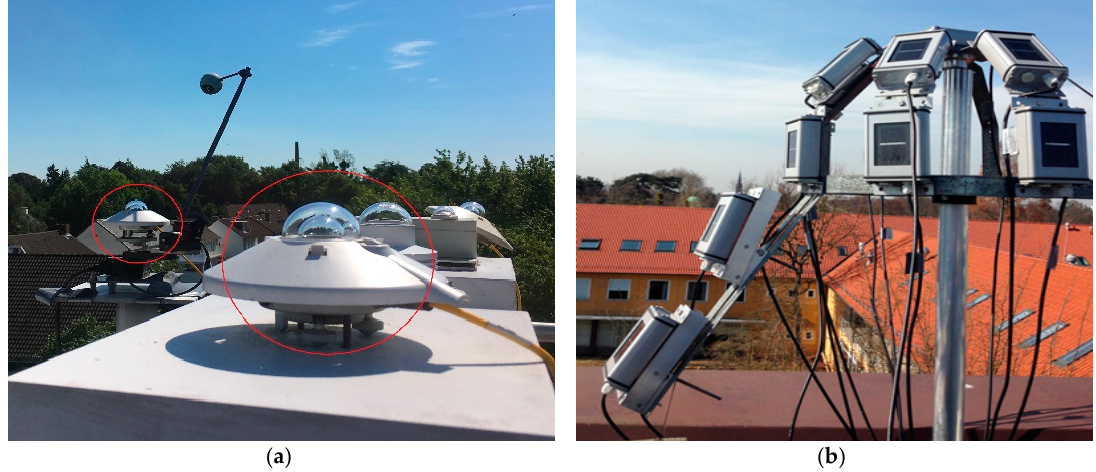
Figure 1. ( a ) Pyranometers and other instruments available and operational at Institute for Meteorology and Climatology (IMUK). ( b ) Set of solar sensors based on silicon detectors mounted in several different tilt angles and orientations, operational at the IMUK (IMUK 2017).